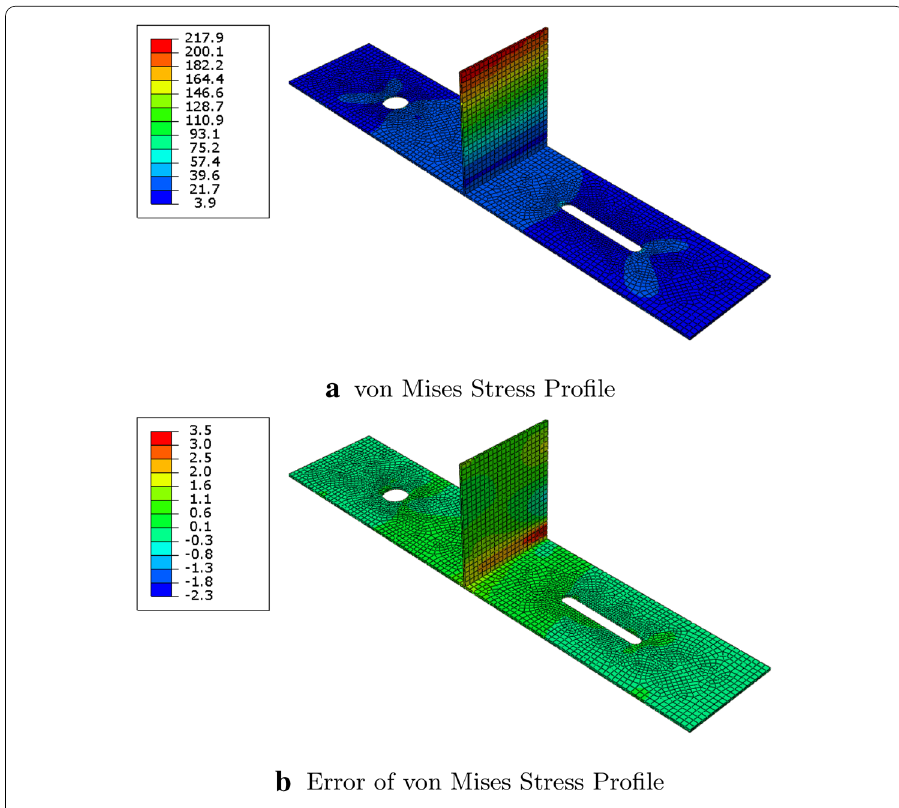
Fig. 9 Slotted hole feature model results in (MPa)